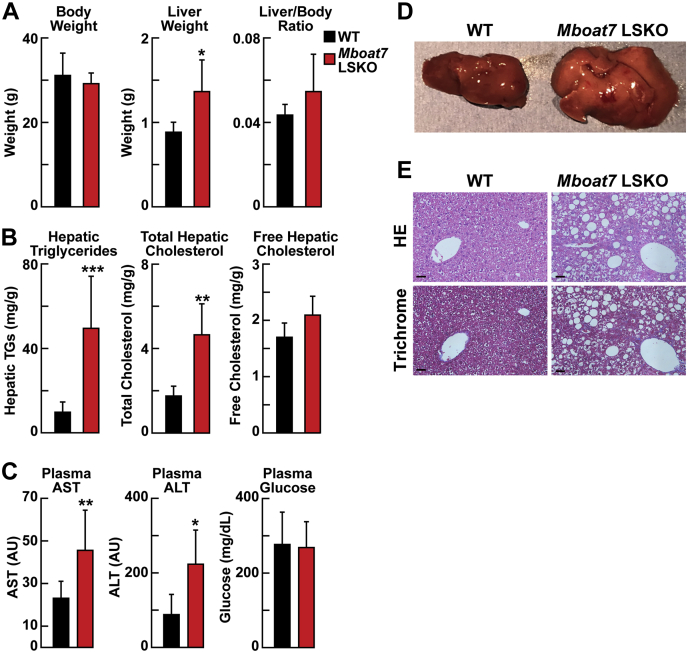
Levels of liver TGs and cholesterol and plasma ALT and AST concentrations in WT and Mboat7 LSKO mice (n = 5 per group). A: Body weight, liver weight, and liver/body weight ratio in WT and Mboat7 LSKO mice. B: Representative liver appearance of 1-year-old WT and Mboat7 LSKO mice fed with a chow diet. Images were taken at the same magnification and distance. C: Liver TGs, total cholesterol, and free cholesterol in WT and Mboat7 LSKO mice. D: Plasma AST, ALT, and glucose. E: Representative liver HE- and trichrome-stained sections of 1-year-old WT and Mboat7 LSKO mice fed with a chow diet. Images are taken at 20× magnification. Length bar represents 20 μm. In A–C, each value represents mean ± SD. The asterisks denote the level of statistical significance (Student's t-test) between WT and Mboat7 LSKO mice: ∗P < 0.05, ∗∗P < 0.005, ∗∗∗P < 0.001. ALT, alanine aminotransferase; AST, aspartate aminotransferase; Mboat7 LSKO, Mboat7 liver-specific KO mice; TG, triglyceride.